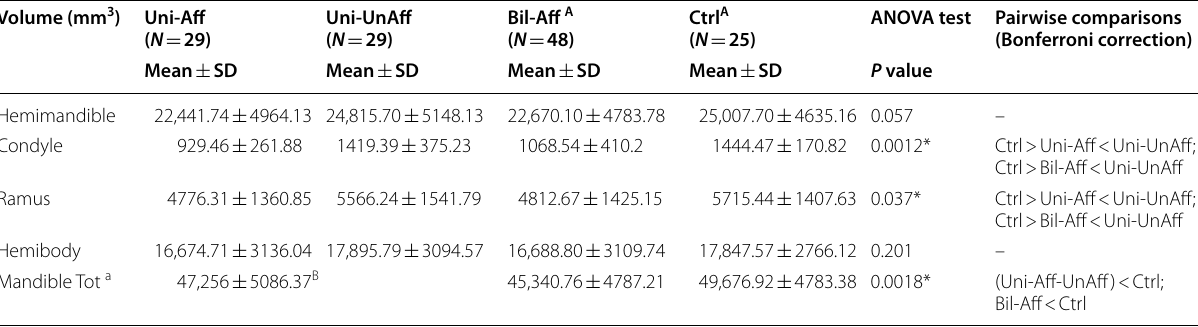
Table 3 Descriptive statistics and statistical comparison with one-way analysis of variance between the following groups: unilateral affected side (Uni-Aff), unilateral unaffected side (Uni-UnAff), bilateral JIA patients (Bil-Aff) and control healthy group